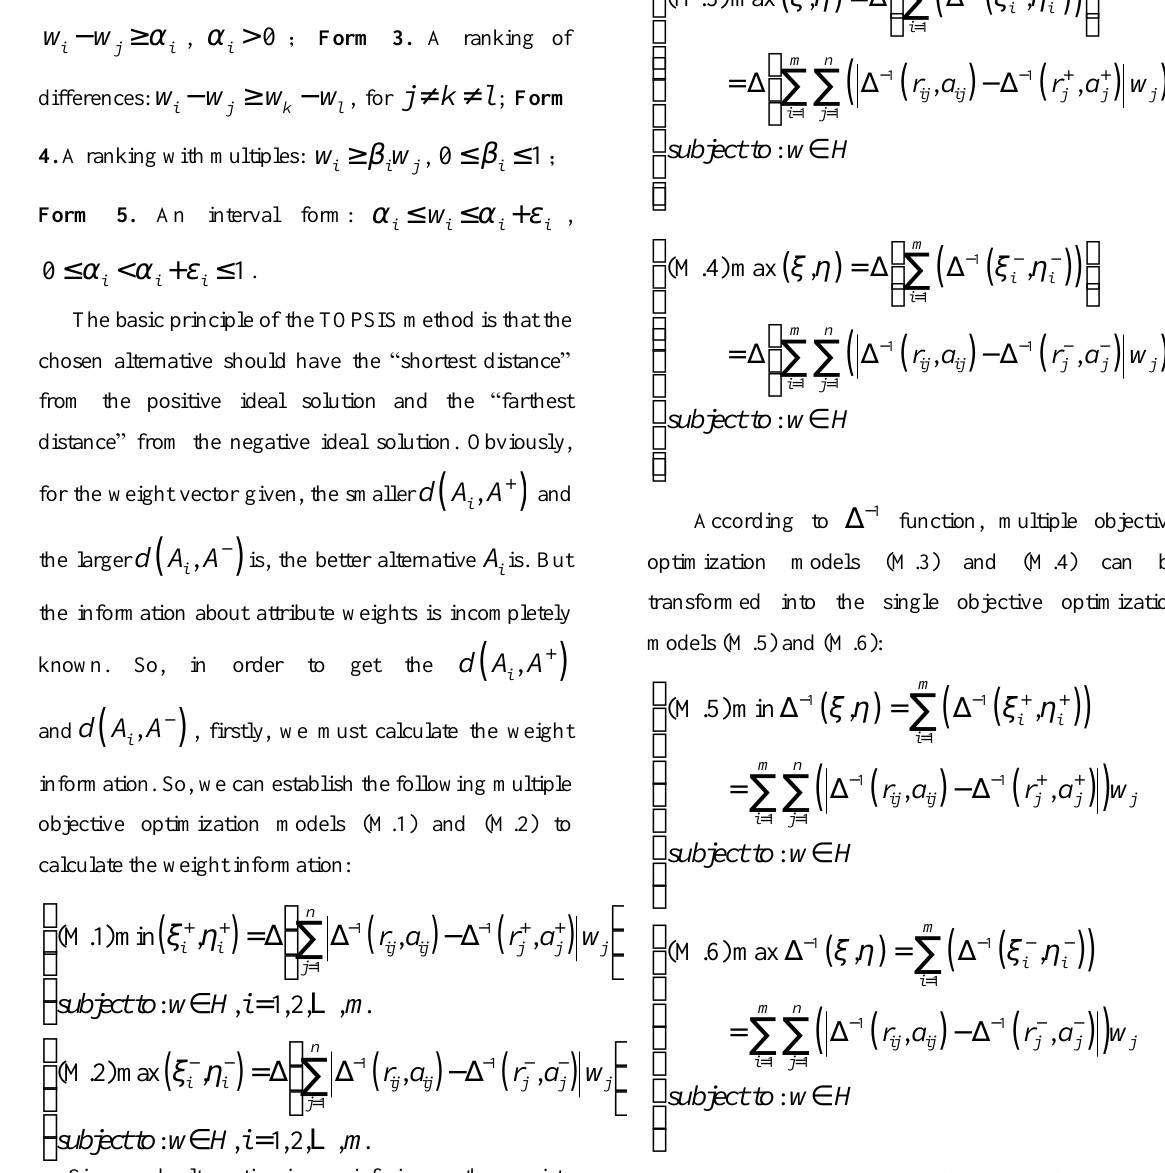
optimal solution and , which can be used as the weight vector of attributes. Then, we can get